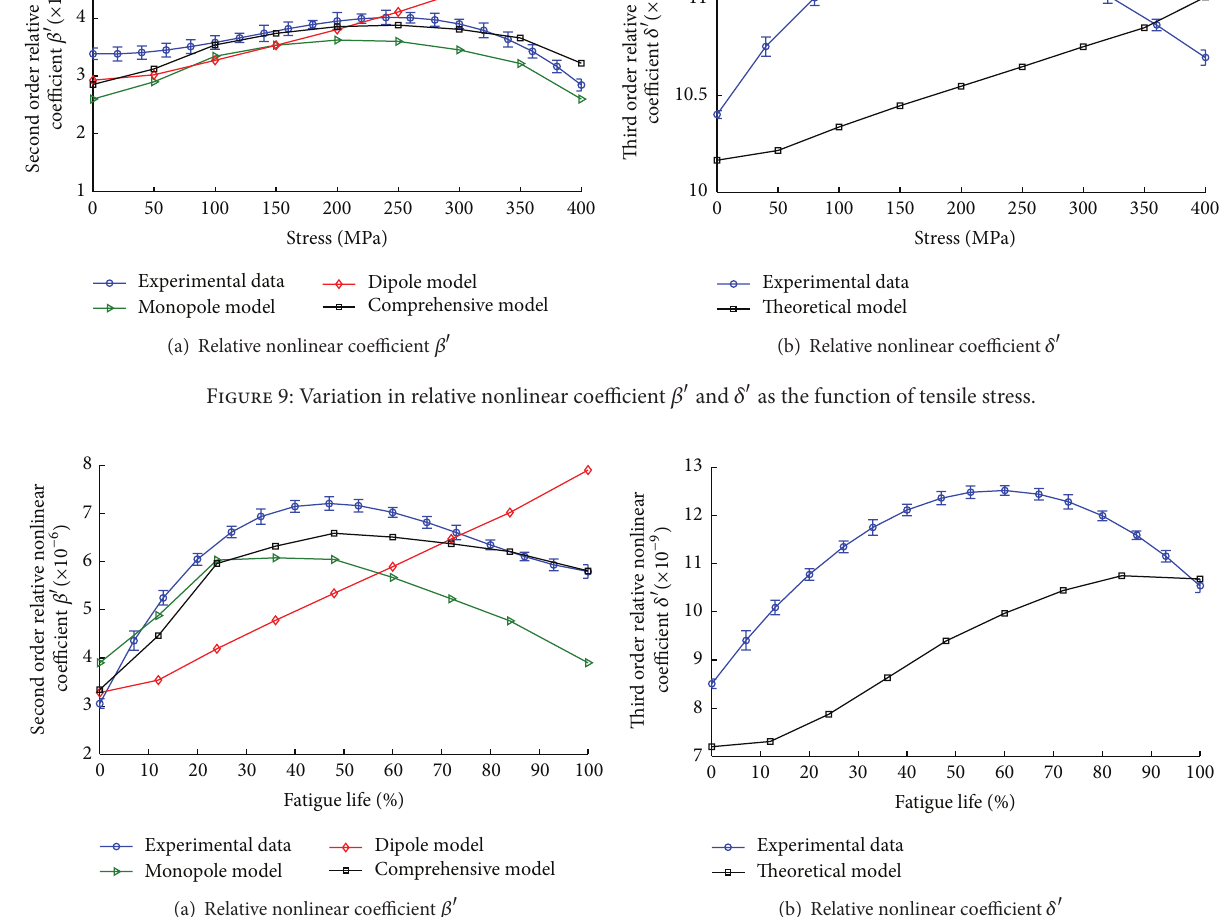
Figure 10: Variation in relative nonlinear coefficients 𝛽 󸀠 and 𝛿 󸀠 as the function of fatigue